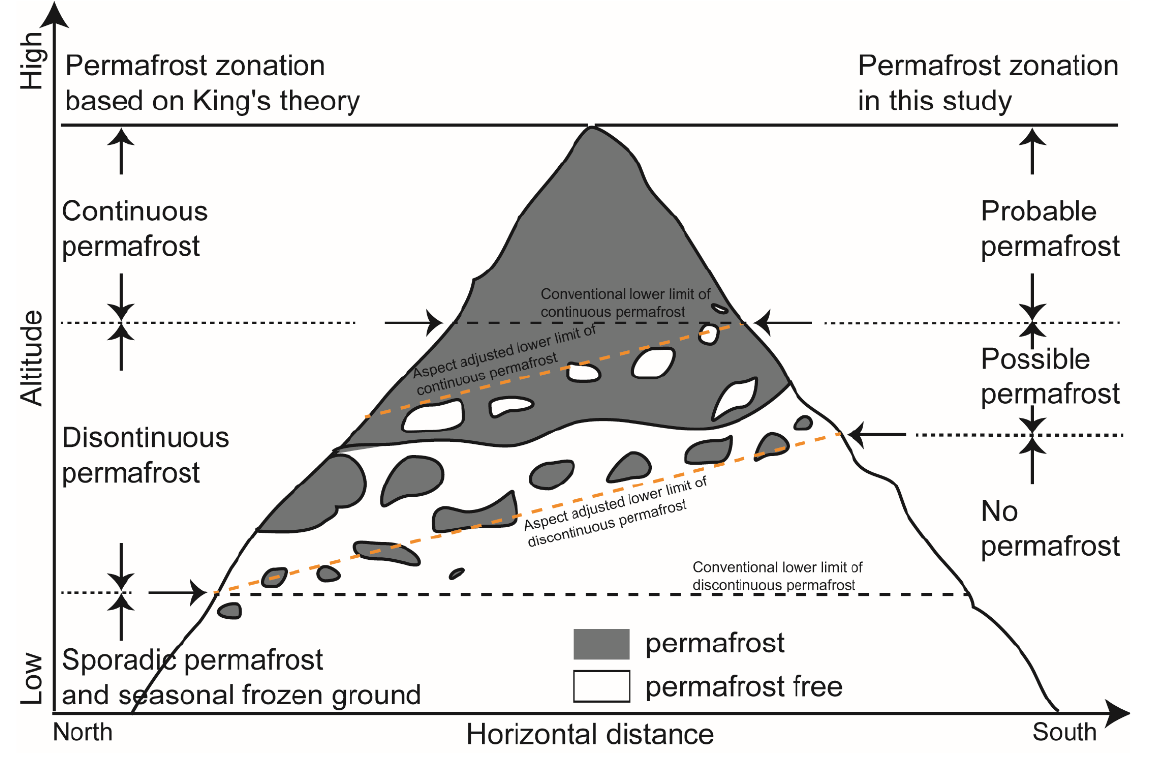
Figure 7. Comparison between the conceptual models of mountain frozen ground zonation based on King’s theory and this research. The illustration was drawn with reference to French’s works [47] and the literature [5,37]. The left side of the graph illustrates the classical conceptual model of mountain permafrost zonation, and the right side shows the development made in this work based on classical theory. The orange dashed lines present adjustments of the lower limit of continuous and discontinuous permafrost under the influence of ASP.